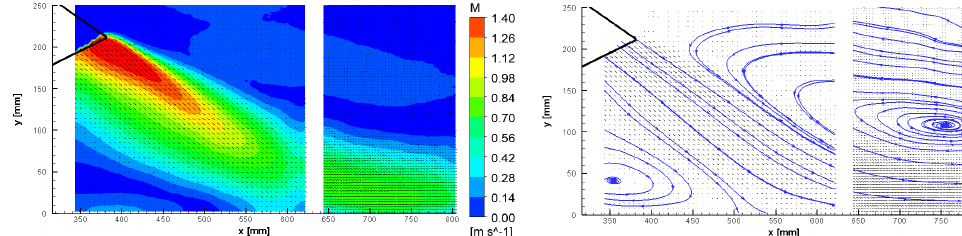
Figure 17. PIV measurements, the magnitude of time-averaged 2D velocity (left panel) and vector lines in vertical plane ( z = − 75mm ) .